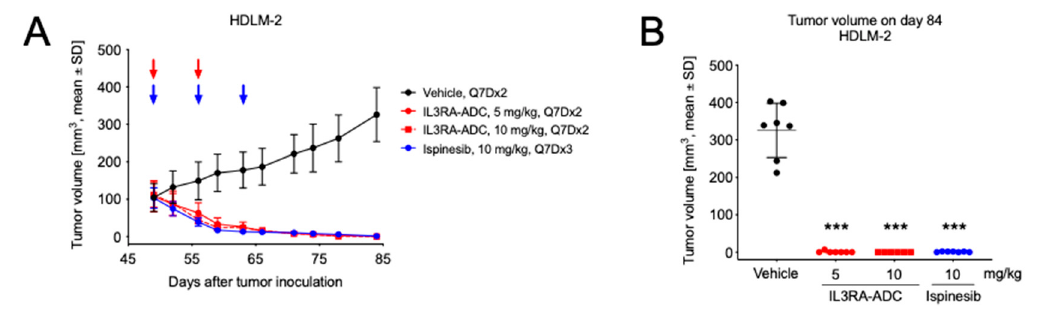
Figure 4. Antitumor e ffi cacy of the IL3RA-ADC BAY-943 in the subcutaneous HDLM-2 Hodgkin lymphoma xenograft model. Mice were transplanted with HDLM-2 cells and treatments with IL3RA-ADC (5 or 10 mg / kg, Q7D × 2, i.p.) or ispinesib (10 mg / kg, Q7D × 3, i.v.) were initiated on day 49. ( A ) Tumor growth curves. ADC treatment days are indicated with red arrows and ispinesib administration is indicated with blue arrows. ( B ) Tumor volume on day 84. Statistical analyses were performed using a linear mixed-e ff ects model with random intercepts and slopes for each subject (n = 6–7). Mean comparisons between the treatment and control groups were performed using the estimated linear mixed-e ff ects model and corrected for family-wise error rate using Sidak’s method. Asterisks indicate statistical significance in comparison to vehicle (*** p < 0.001).